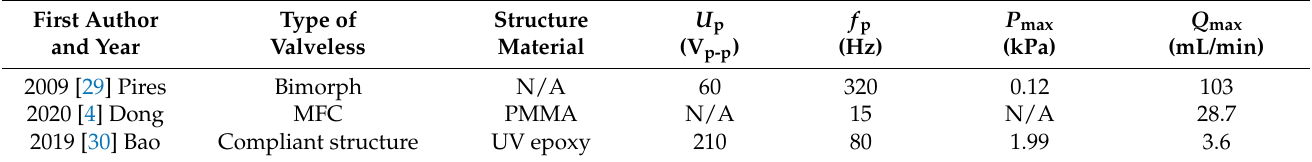
Figure 6. Working principle of a valveless piezoelectric pump imitating a caudal-fin. Table 5. Summary of properties for the bionic valveless piezoelectric pump.